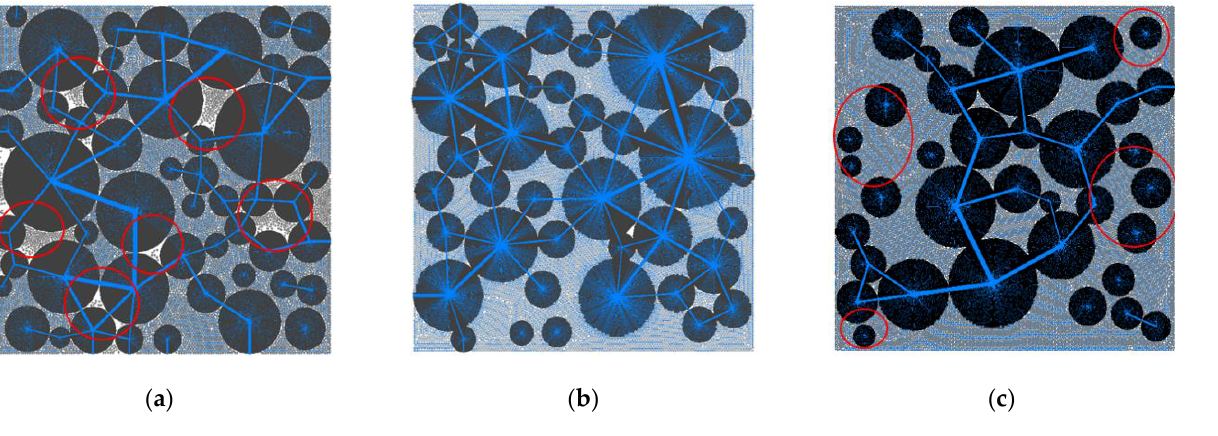
Figure 10. Element model of phosphorus tailing – graded waste rock mixture. ( a ) 𝑞 𝑓 < 23%, ( b ) 23% < 𝑞 𝑓 < 30%, ( c ) 30% < 𝑞 𝑓 .